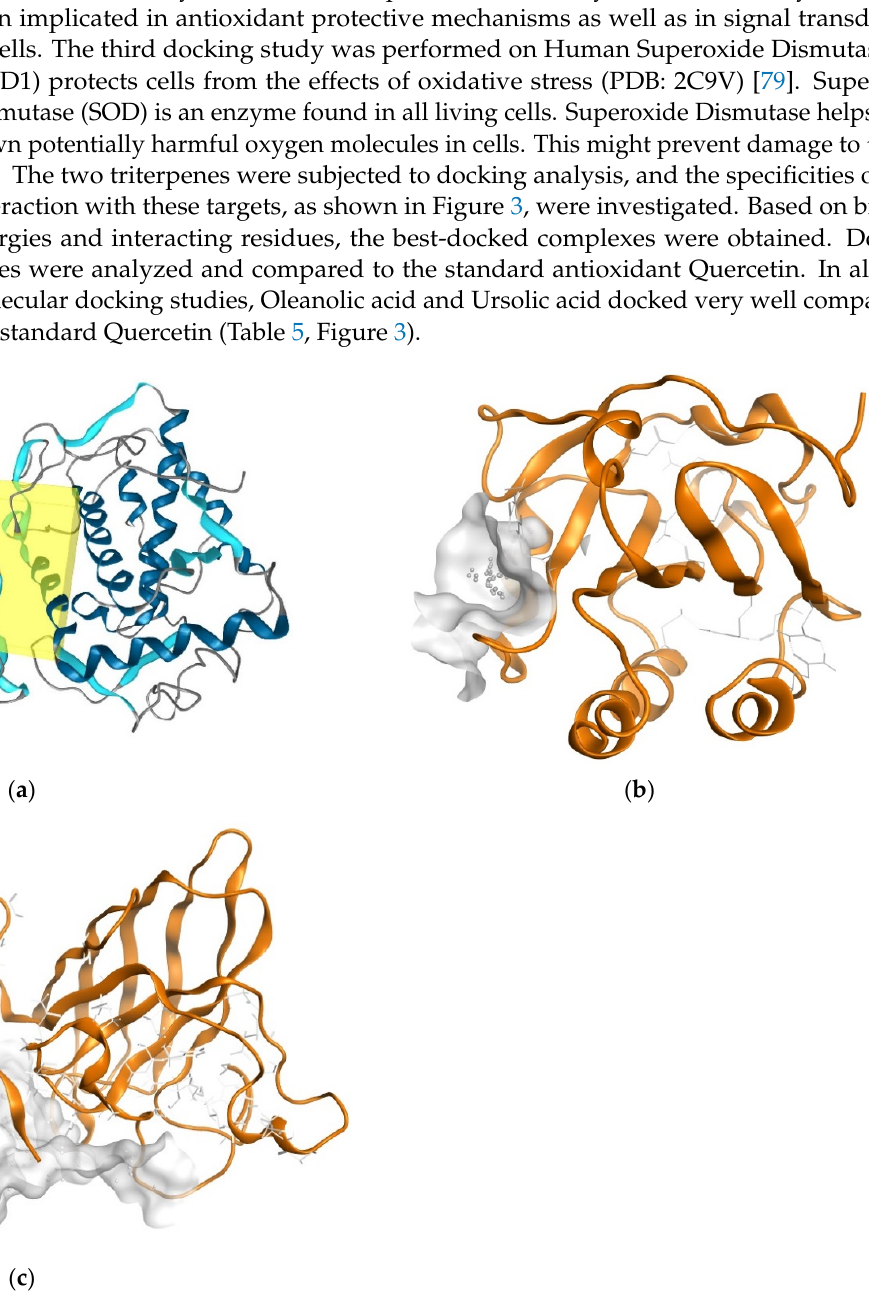
Figure 3. Binding site (yellow color) of tyrosinase from Bacillus megaterium ( a ); Binding site (grey- white color) of Human Peroxiredoxin 5 ( b ); Binding site (grey-white color) of Superoxide Dismutase (SOD1) ( c ).